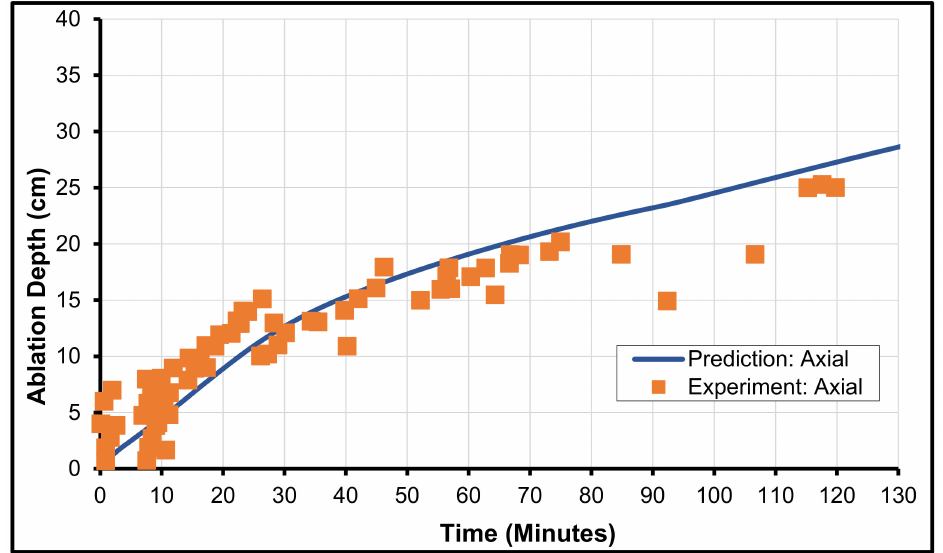
Figure 6. Comparison of SURC-2 experimental concrete axial ablation data with the developed model.